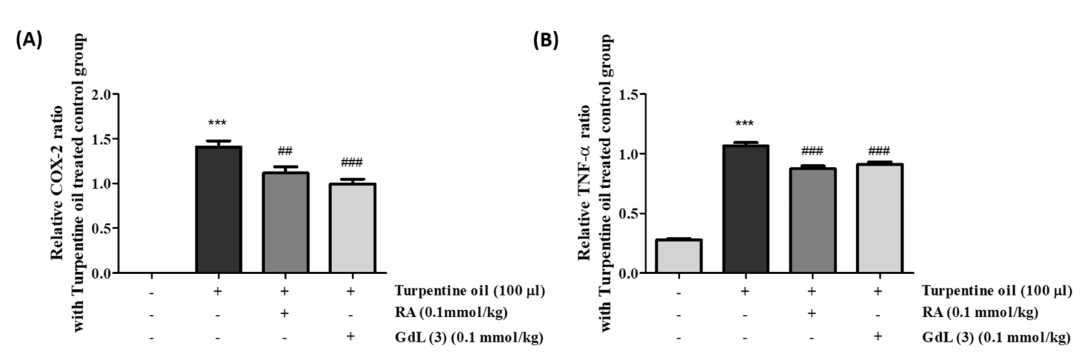
Figure 7. Anti-inflammatory e ff ects of RosA and GdL (3) on PA-induced inflammation in C2C12 cells. The mRNA expression levels of ( A ) cyclooxygenase-2 (COX-2) and ( B ) tumor necrosis factor (TNF)- α according to drug concentration. * p < 0.05, *** p < 0.001 significant di ff erence from the control. # p < 0.05, ## p < 0.01, and ### p < 0.001, significant di ff erence from PA. This experiment was shown by averaging the results of three independent experiments.